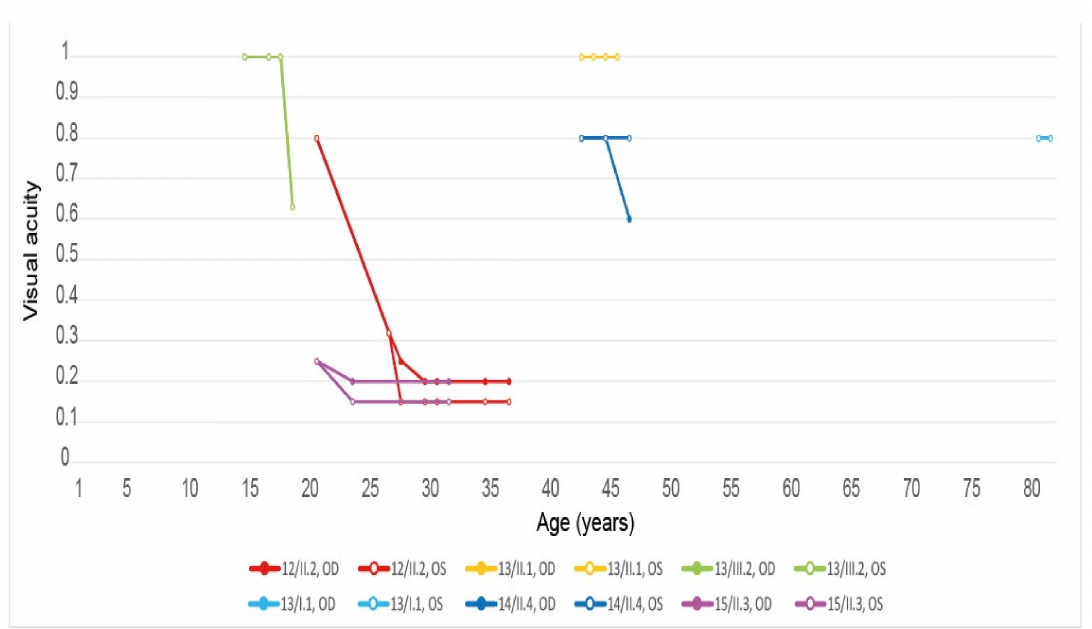
Figure 6. Evolution of the visual acuity in patients harboring the pathogenic c.810C>G, p.(Tyr270*) ELOVL4 variant. Best corrected visual acuity was assessed at indicated age (years), each dot indicating a clinical examination. OD, right eye; OS, left eye. Patient descriptions in text and